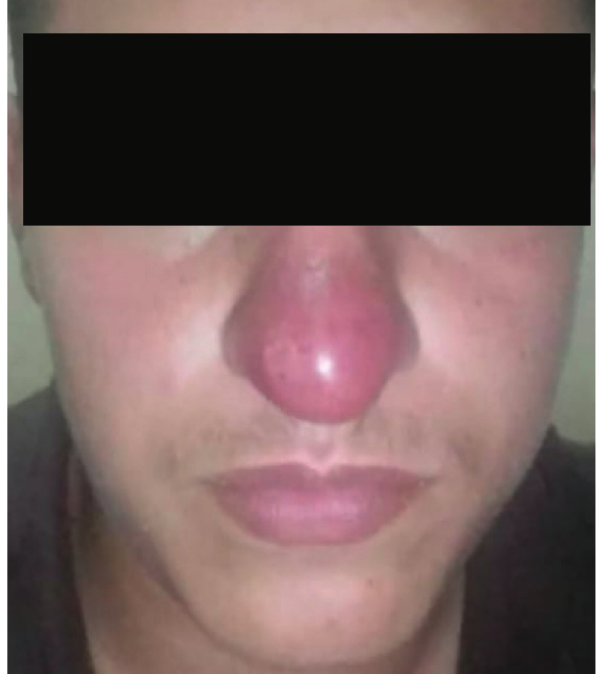
Figure 2: Erythematous appearance covering the entire lobe of the